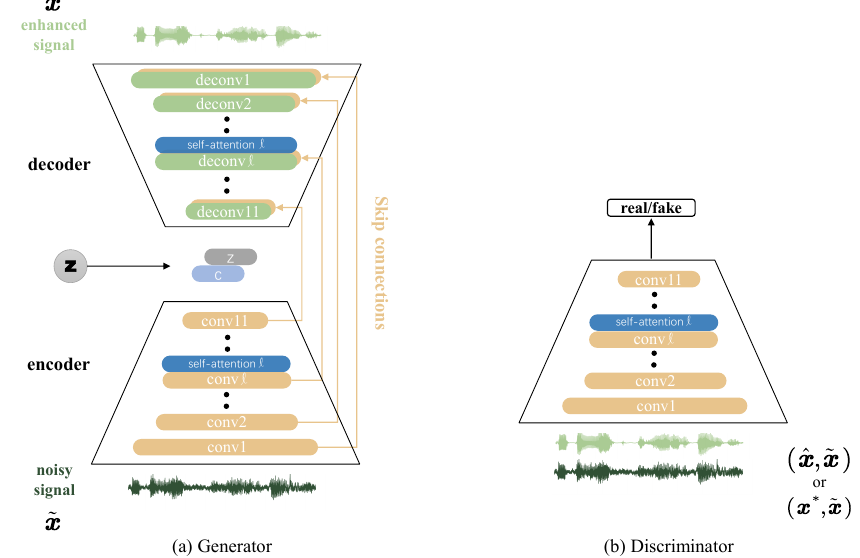
Figure 4. Illustration of the attention augmented convolutional SEGAN architecture. ( a ) The genera- tor component. ( b ) The discriminator